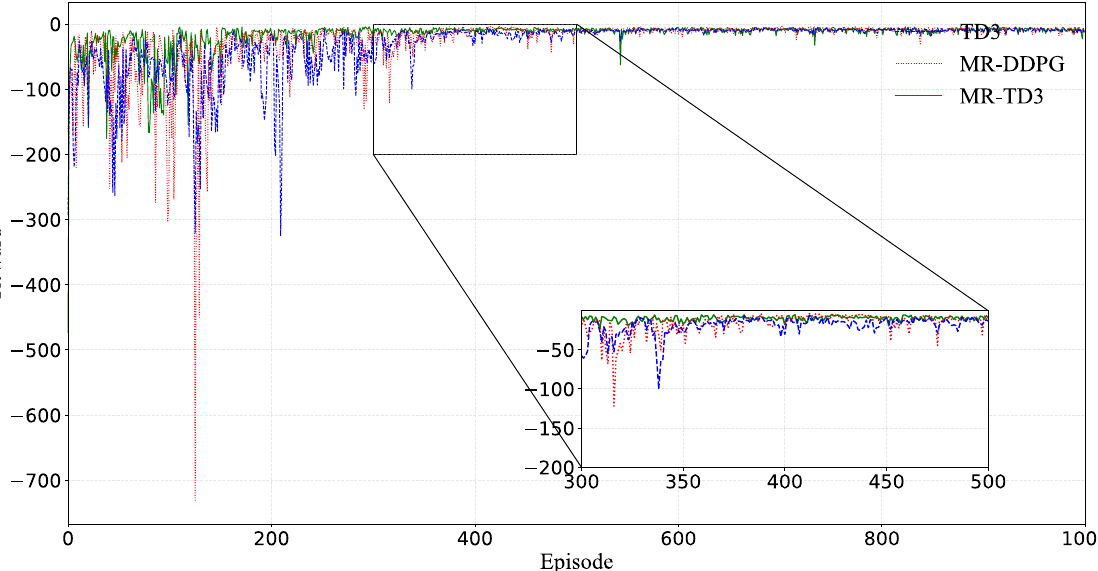
Figure 6. Training reward for TD3, MR–DDPG and MR–TD3. The x-axis is the episode and the y-axis is the reward of each episode. The magnification area is from the 300th to the 500th episode, and the y-axis range is between − 200 and